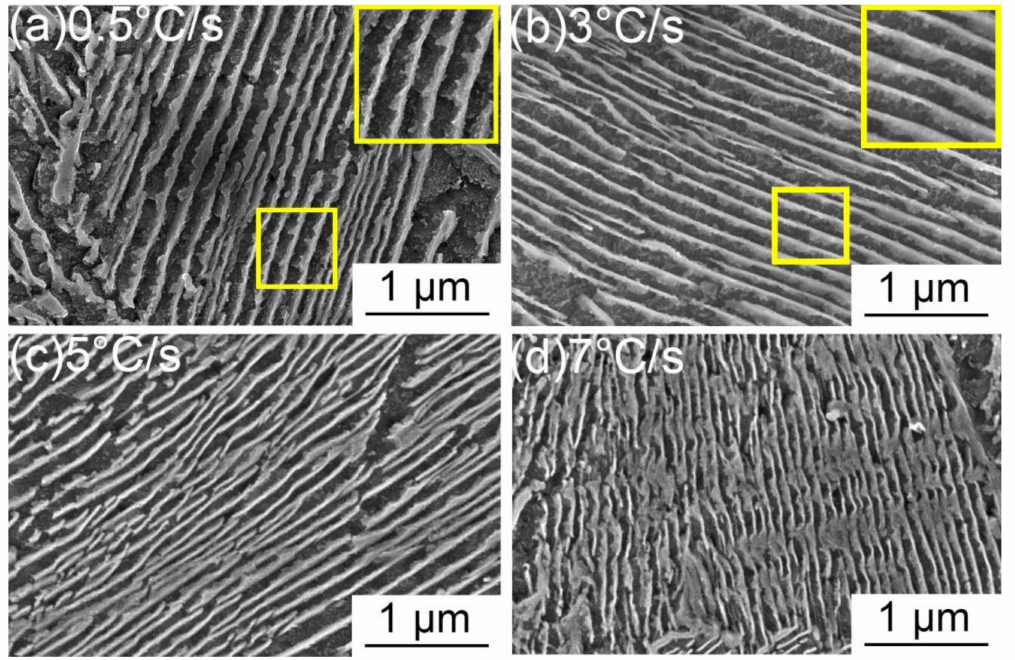
Figure 6. Microstructure of specimens cooled at ( a ) 0.5 ◦ C / s, ( b ) 3 ◦ C / s, ( c ) 5 ◦ C / s, and ( d ) 7 ◦ C / s. Table 2. Quantification of the ferrite and pearlite of specimens cooled at di ff erent rates. V f is the volume fraction of the ferrite, S p is the lamella space of pearlite colony, and d p is the grain size of pearlite. Cooling Rates ( ◦ C / s) V f (%) S p (nm) d p ( µ m) HV 0.5 23 380 139 347 3 8 263 102 369 5 6 179 82 385 7 2 117 61